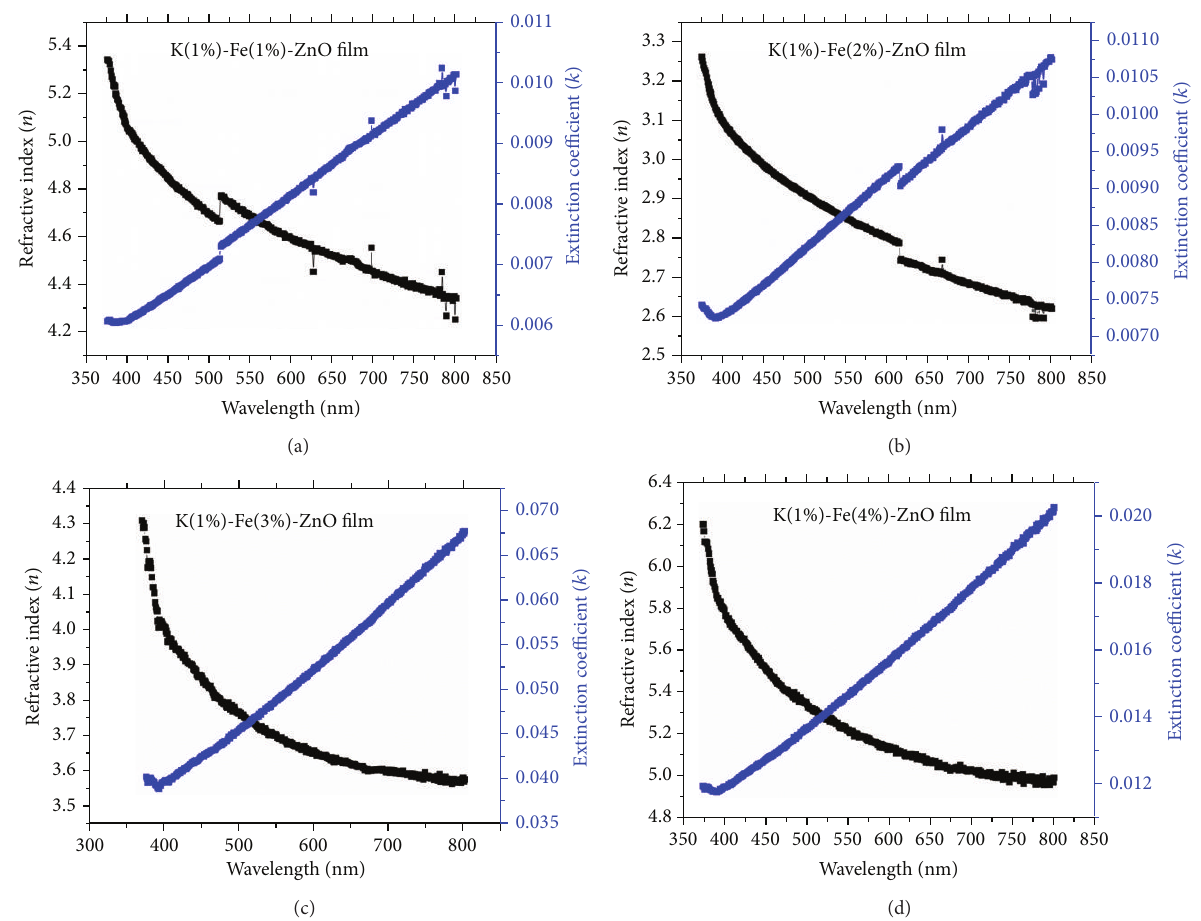
Figure 7: Refractive index of (K (1%), Fe) codoped ZnO for Fe concentrations: (a) 1%, (b) 2%, (c) 3%, and (d) 4%.